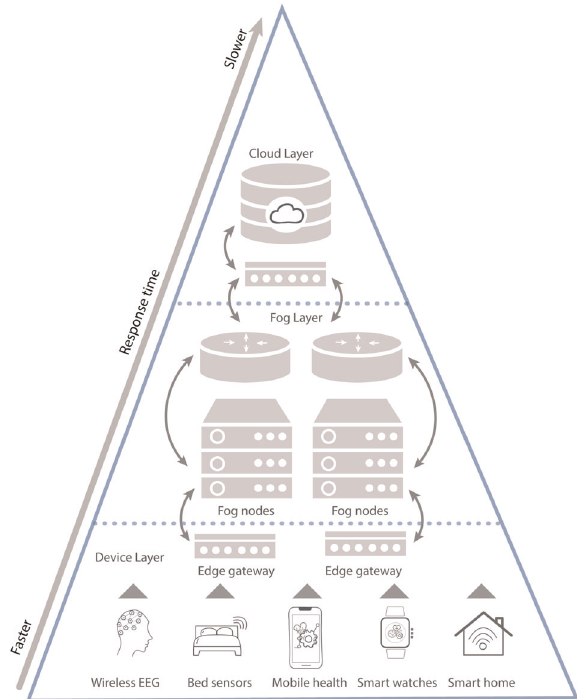
Fig. 5 Overview of cloud computing-based sleep data acquisition and storage. This illustration provides an overview of the process starting with device layer (which includes fast, real-time processing and data visualisation, embedded systems, gateways and micro data storage), followed by the fog layer (which includes local networks, virtualisation, data analysis and reduction) and fi nally cloud layer (which consists of data centres and big data storage and